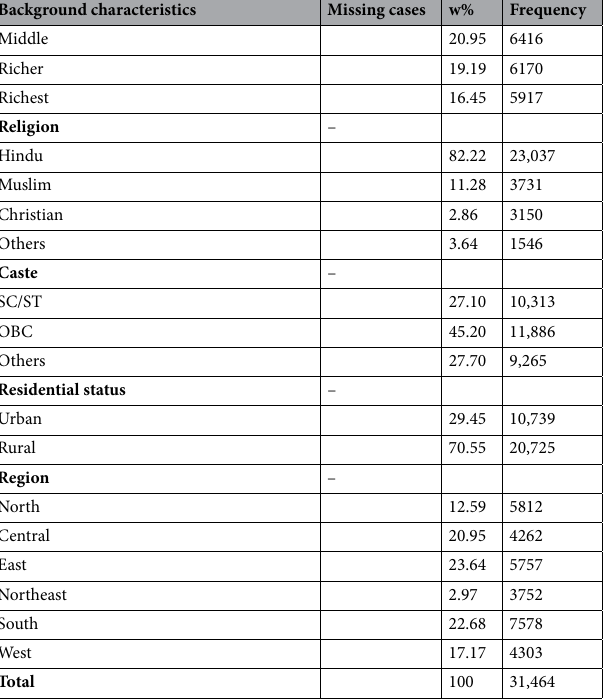
Table 1. Socio-economic and health profile of older adults in India. w%: weighted percentage prevalence to provide national population estimates; Counts are unweighted; SRH: Self-Rated Health; ADL: Activities of daily living; IADL: Instrumental activities of daily living; MPCE: Monthly per capita consumption expenditure; SC/ST: Scheduled caste/Scheduled tribe; OBC: Other backward